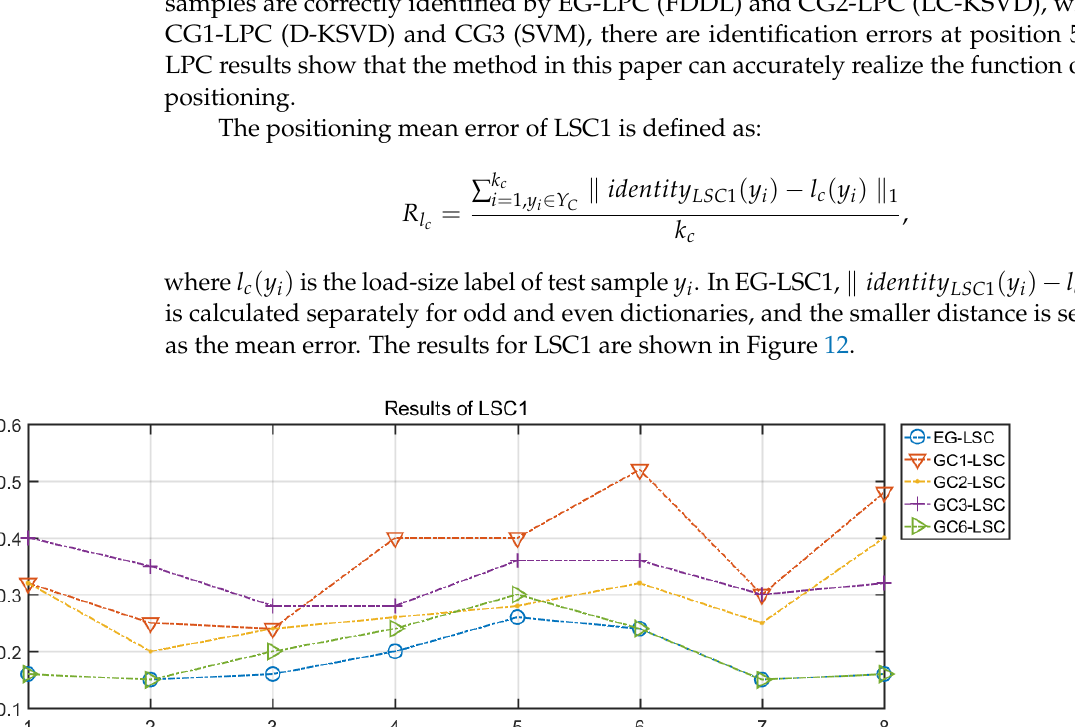
Table 4. Mean errors of each method.